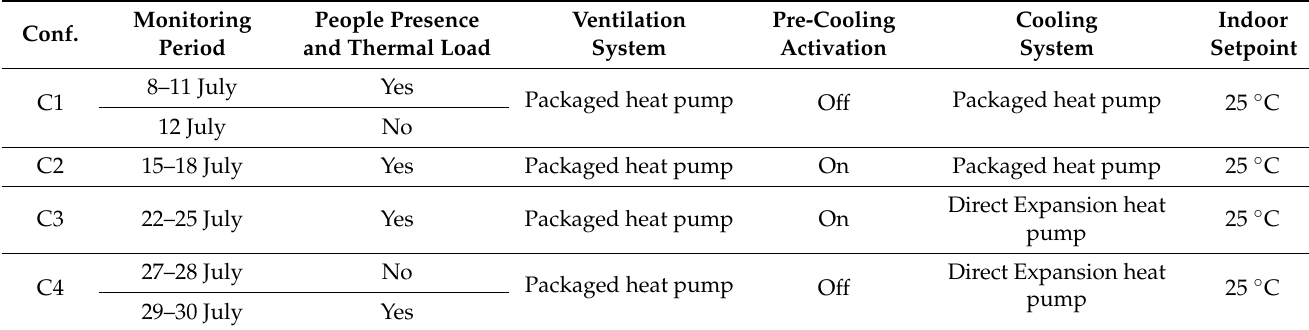
Table 2. Information about tested HVAC